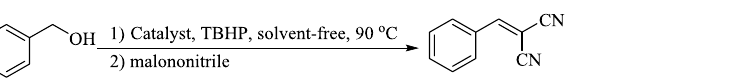
Figure 17. Reaction between benzyl alcohol and malononitrile for the synthesis of 2-benzylidenemalononitrile.